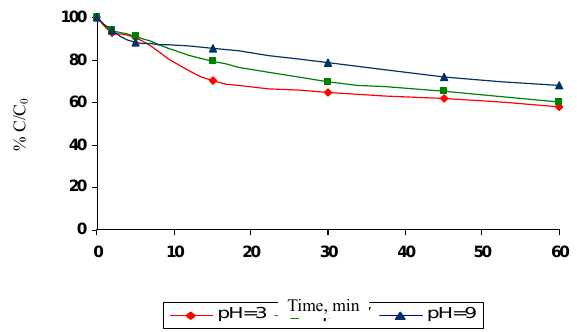
Figure 5. Effect of pH on nano-ZnO catalyzed ozonation of 4NCB [ZnO] = 300 mg/L; ] = 5.64 mg/L; [4NCB] [O 3 o